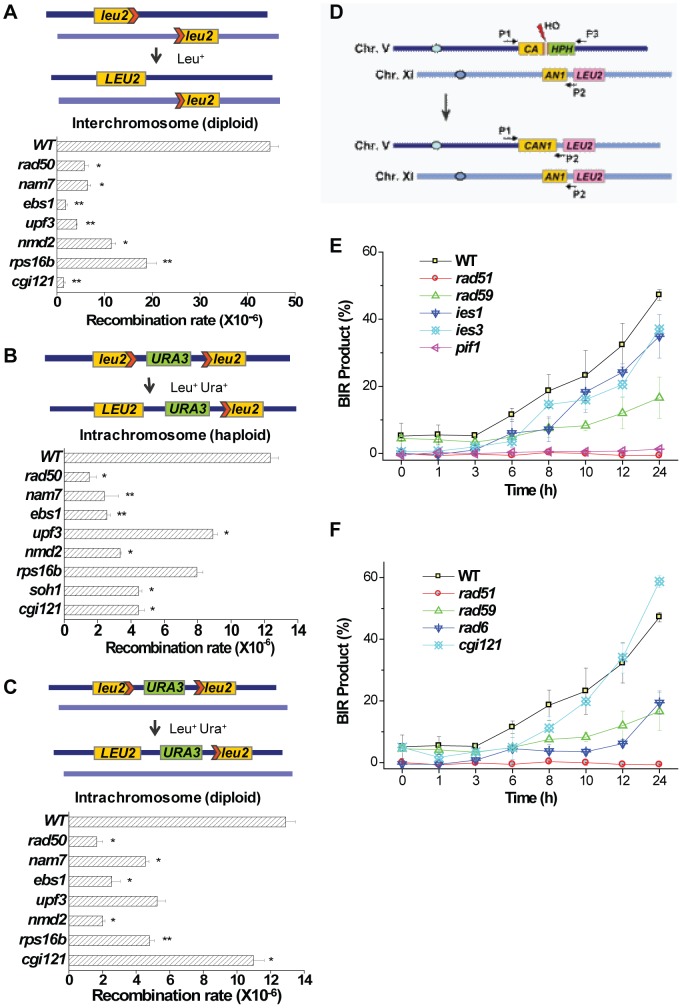
General homologous recombination activities in nam7Δ, ebs1Δ, upf3Δ, nmd2Δ, rps16bΔ, soh1Δ, and cgi121Δ mutants, and break-induced-replication efficiencies in ies1Δ, ies3Δ, pif1Δ, rad6Δ, and cgi121Δ mutants.(A) Inter-chromosomal recombination assay in the indicated homozygous diploid deletion mutants. (B) Intra-chromosomal recombination assay in the indicated haploid mutants. (C) Intra-chromosomal recombination assay in the indicated homozygous diploid deletion mutants. The upper panels are the schematic illustrations of each recombination event. The lower panels show the measured recombination rates in the indicated mutants. These assays were performed as reported previously [72], [73] and the statistical significance was indicated as follows: **P-value<0.02 and *P-value<0.05. The rad50Δ mutant was included as a positive control. We failed in constructing soh1Δ homozygous mutants in (A) and (C) because the mating efficiency of this mutant was extremely low. (D) Schematic illustration of the system to detect break-induced-replication (BIR) efficiencies as reported in Lydeard et al [74]. After galactose induction, HO endonuclease causes a break in the indicated site, BIR repair process generates an intact CAN1 marker which can be detected by PCR procedures using primers P1 and P2. (E and F) BIR efficiencies were measured in pif1Δ, ies1Δ and ies3Δ mutants (E), and rad6Δ and cgi121Δ mutants (F). Semi-quantitative PCR was used to measure BIR efficiency as shown in Figure S6.